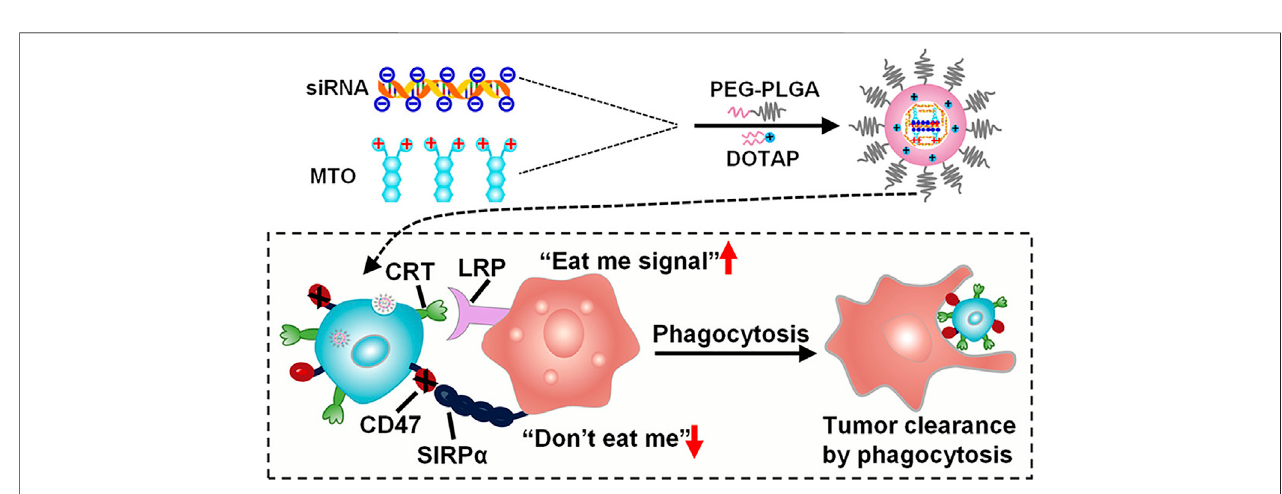
FIGURE 3 | The diagram of PLGA-based nanoparticles for the simultaneous delivery of siRNA and mitoxantrone hydrochloride (MTO · 2HCl) (Zhang Y. et al., 2021)